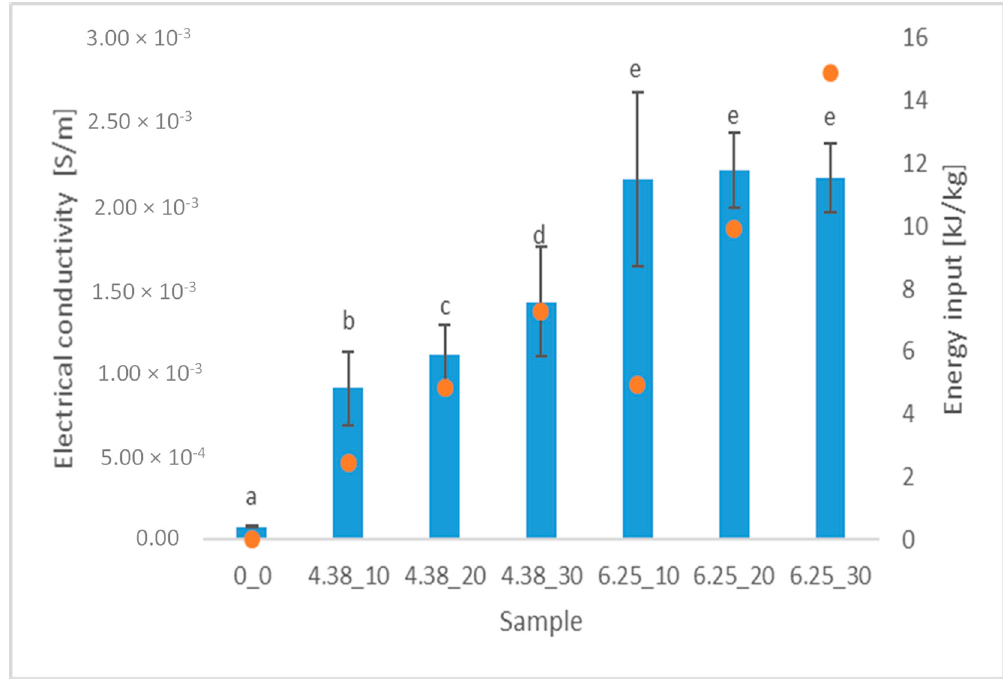
Figure 1. Electrical conductivity S / m (bars) and total energy input kJ / kg (dots) of di ff erently treated beetroot samples. The same letter on the same column means no significant di ff erence between electrical conductivities by the Tukey test ( p <